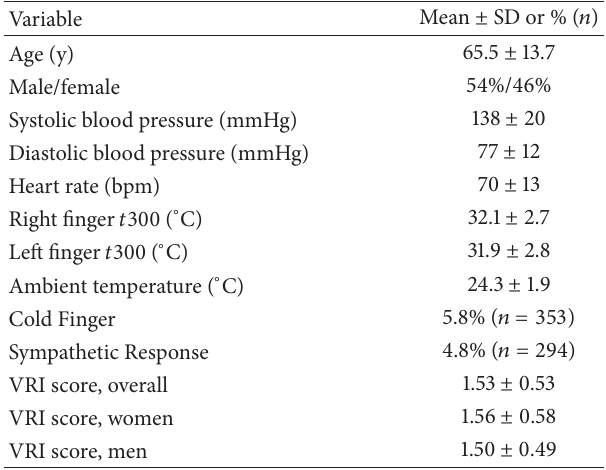
Table 1: Selected patient and test